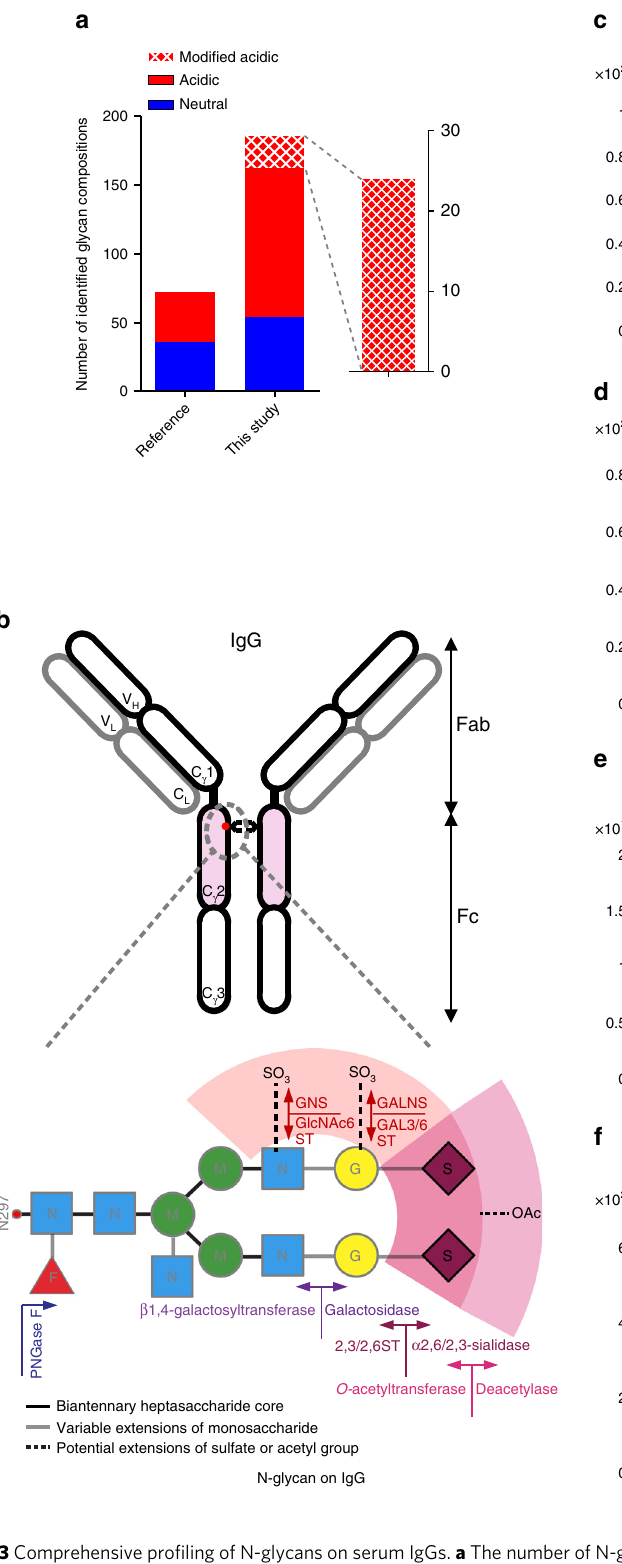
Fig. 3 Comprehensive pro fi ling of N-glycans on serum IgGs. a The number of N-glycans characterized on serum IgGs using the TiO 2 -PGC chip coupled with Q-TOF MS. b Structural maps of N-glycans on IgG. c – f MS/MS of representative sulfated